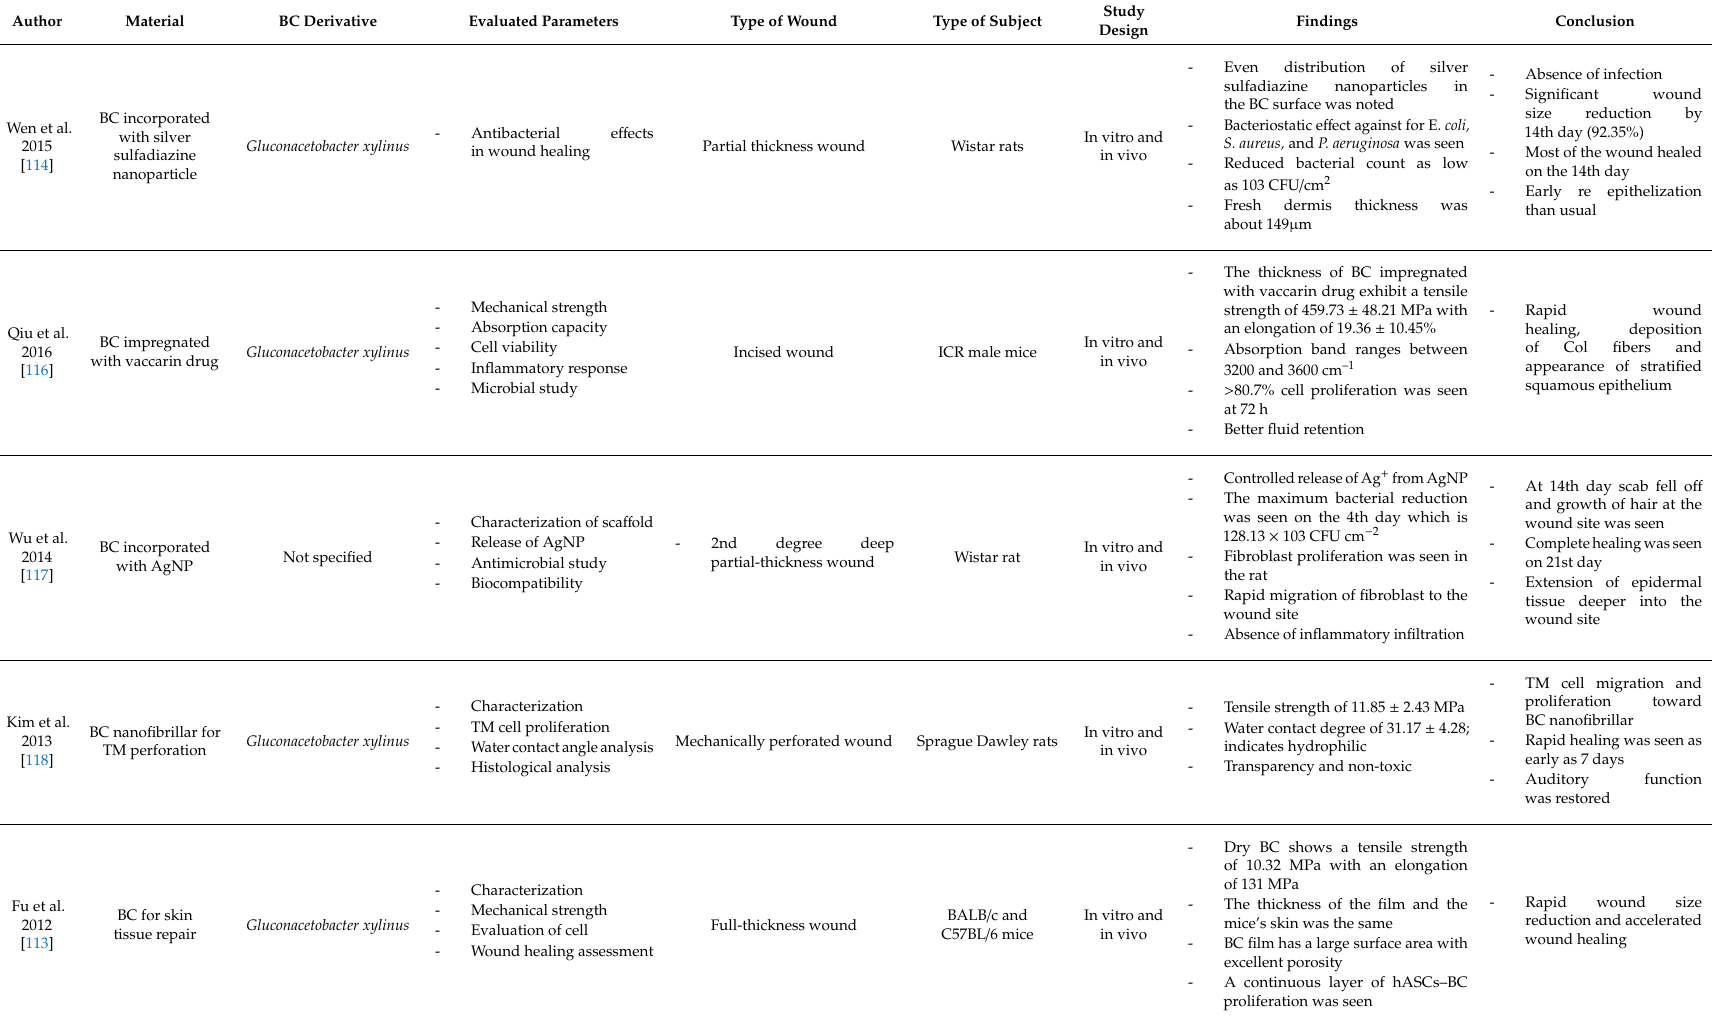
Table 3. In vivo and in vitro studies of bacterial